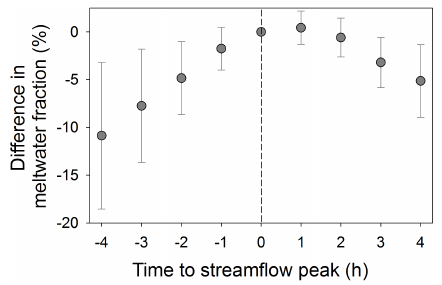
Figure 6. Average difference between the meltwater fraction in streamflow at the time of streamflow peak and the meltwater frac- tion at different hours from the time of streamflow peak for the melt- induced runoff events at S5-USG and S3-LSG in 2011–2013. Error bars represent the standard deviation. The vertical line indicates the time of streamflow peak.